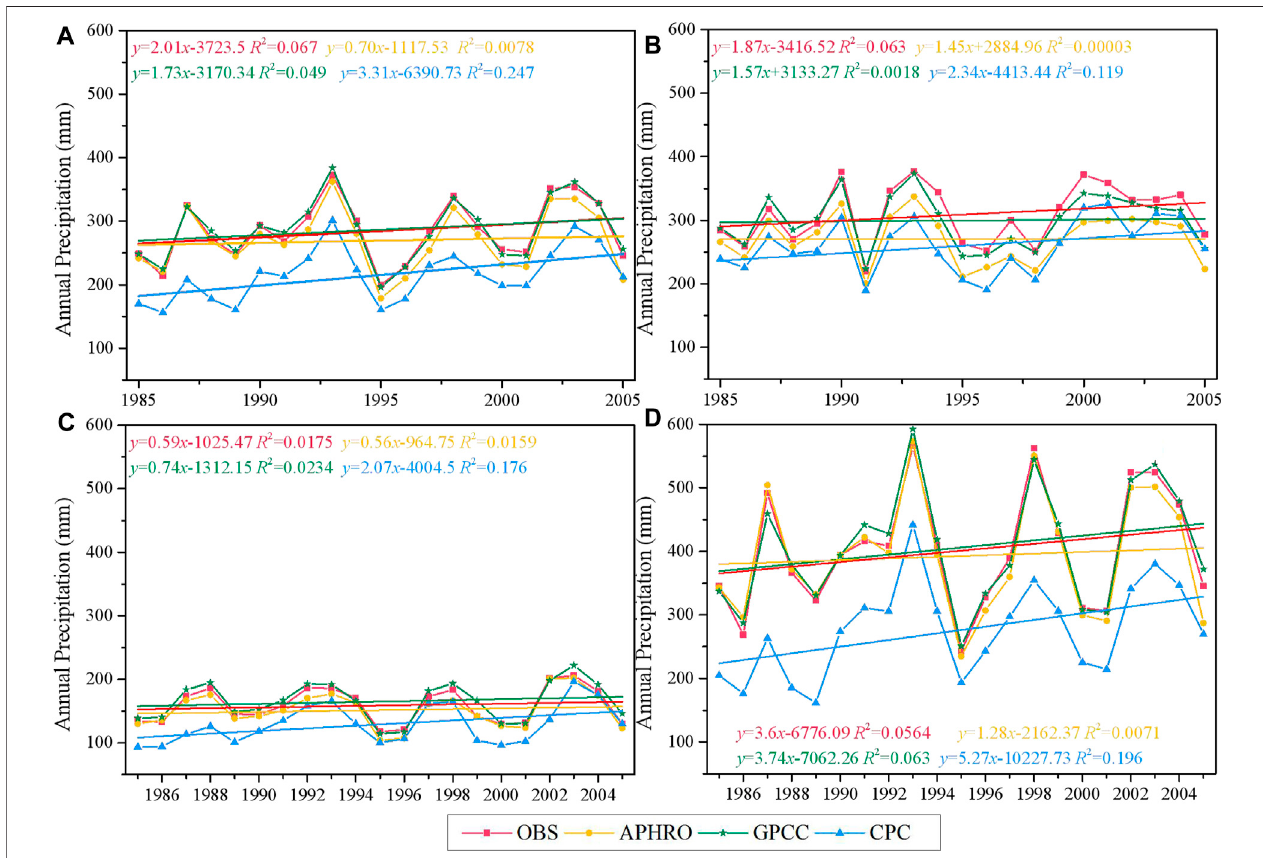
FIGURE 9 | Annual precipitation variations for OBS (red line with square), APHRODITE (yellow circled line), GPCC (green pentagonal line), and CPC (blue line with triangles) in the CA (A) , NCA (B) , SWCA (C) , and SECA (D) from 1985 to 2005 ( unit:mm ).